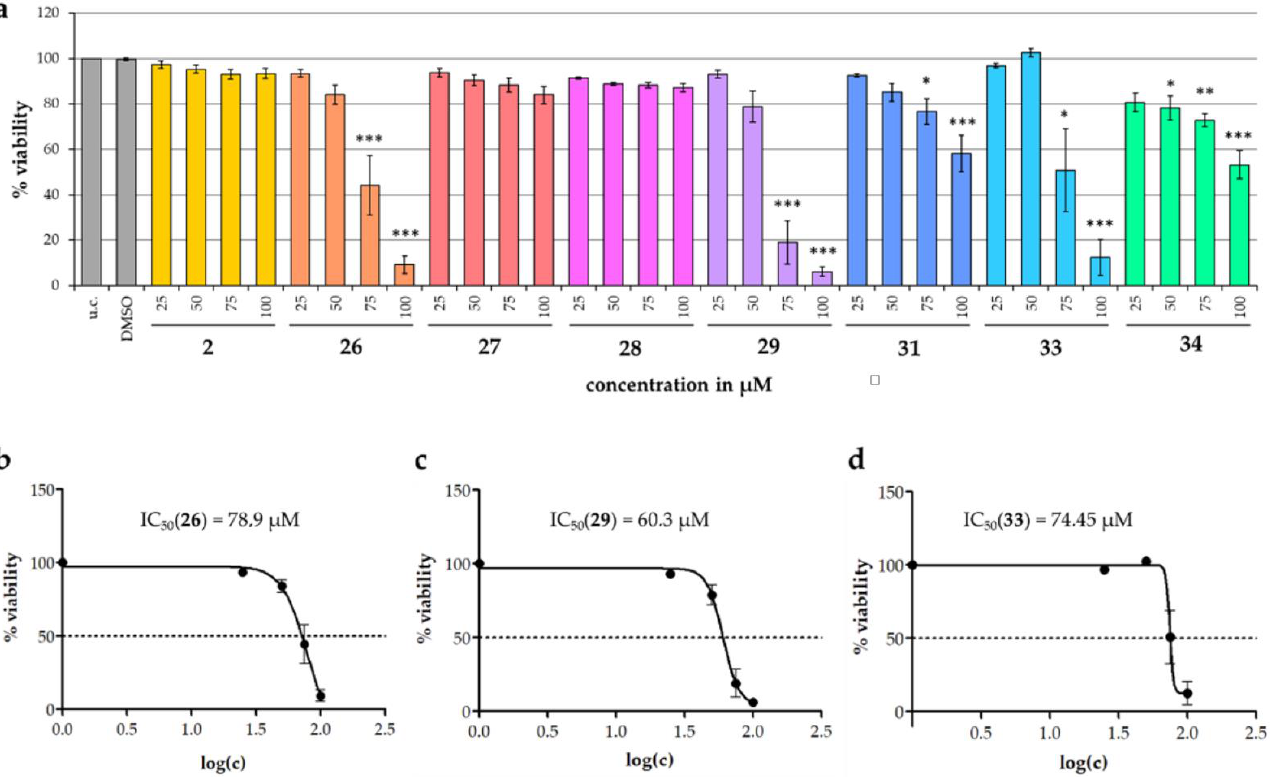
Figure 13. ( a ) Influence of compounds 2 , 26 - 29 , 31 , 33 and 34 on the viability of HeLa cells in the MTT assay. The test was performed with pure medium (u.c.), the highest used concentration of DMSO (0.2%, v/v) and substance concentrations between 25 and 100 μM. Data are presented as mean +/- SEM; * p < 0.05, ** p < 0.01, *** p < 0.001 vs. u.c. (Tukey-HSD, n = 3). Additionally, nonlinear regression curves of compounds 26 ( b ), 29 ( c ) and 33 ( d ) and their corresponding IC 50 values are presented.